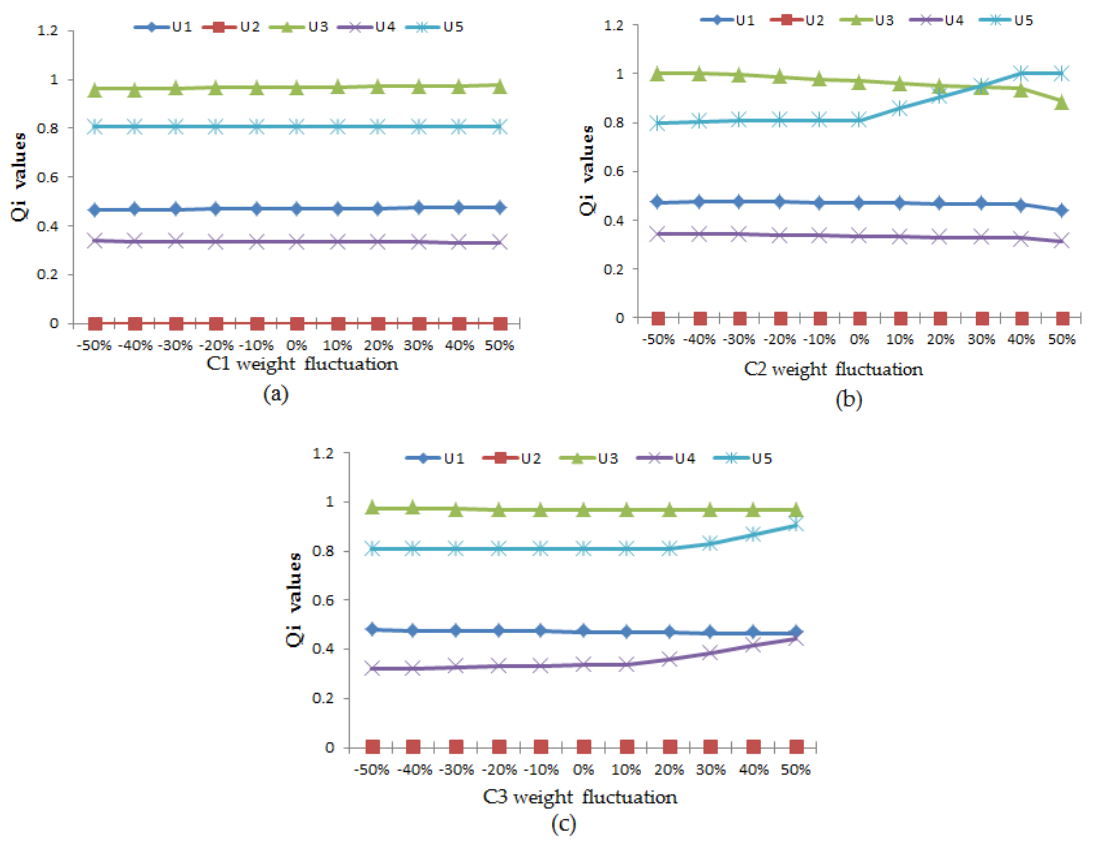
Figure 5. Weight sensitivity analysis for economic benefits criteria. ( a ) Weight sensitivity analysis for sub-criterion C1. ( b ) Weight sensitivity analysis for sub-criterion C2. ( c ) Weight sensitivity analysis for sub-criterion